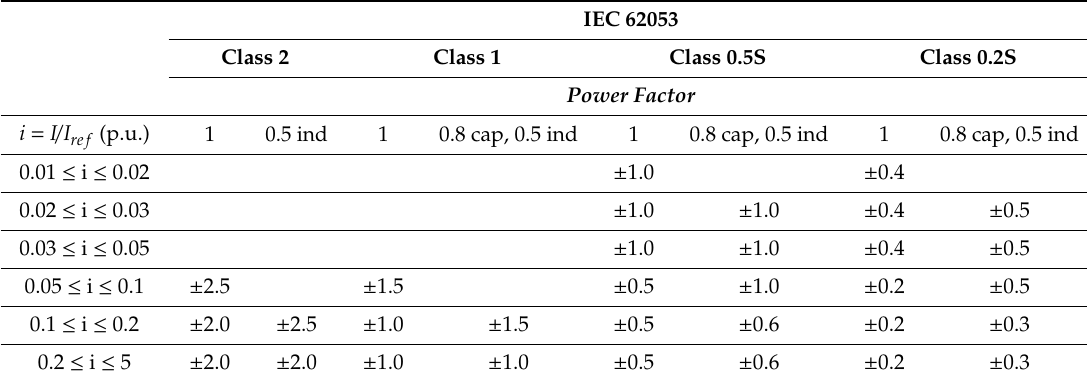
Table 2. Percentage error limits defined by IEC 62053-21,